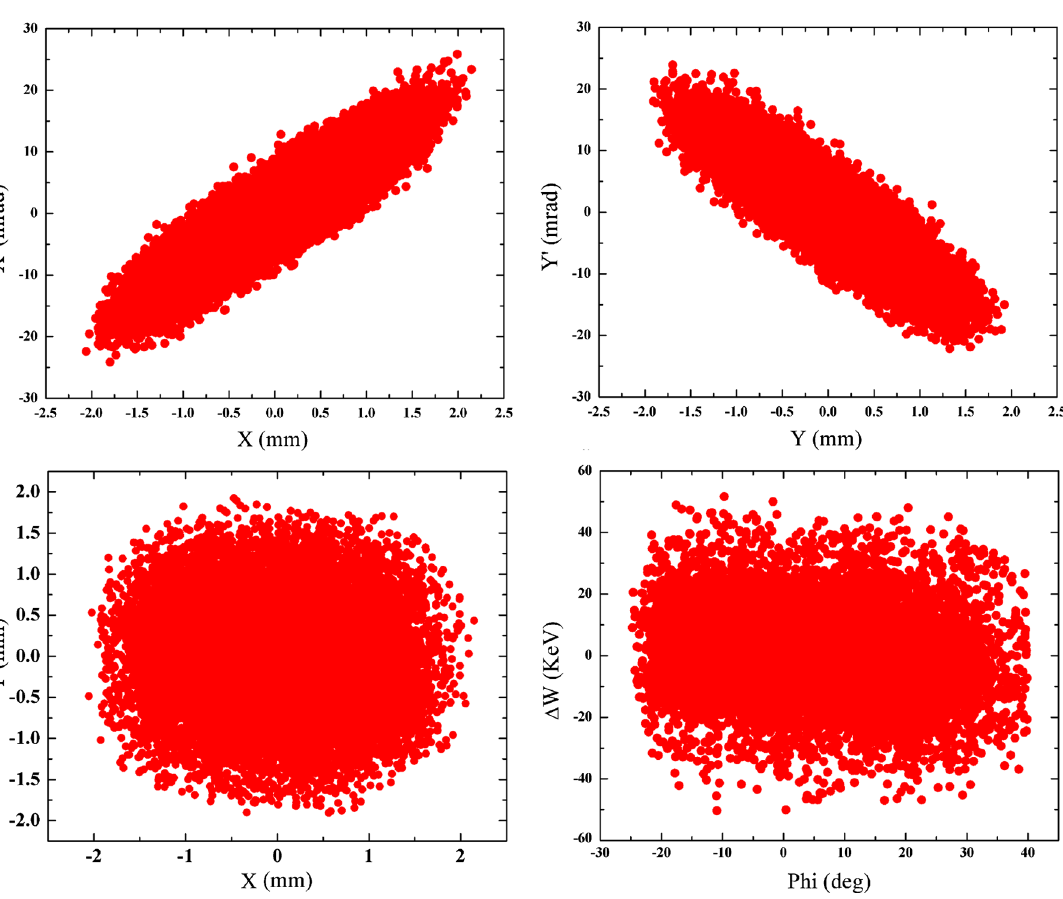
FIG. 32. The particle distribution at the exit of the